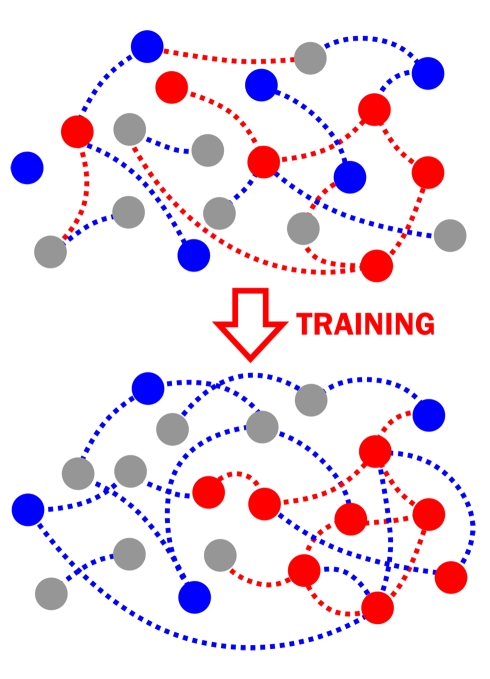
Schematic of receptive field and noise correlation plasticity for trained (red) and untrained (blue) stimuli.Tectal neurons are represented as circles, circle color marks preferred direction (red, down; blue, up), and dotted lines represent noise correlations. Training with down direction increases and clusters receptive fields oriented toward the trained stimuli and decreases long-distance noise correlations (dashed lines). Receptive fields preferring untrained stimuli (blue) are reduced, and noise correlations to these stimuli are increased on all spatial scales. Note that noise correlations can differ across stimuli and are not necessarily determined by neurons' preferred directions.